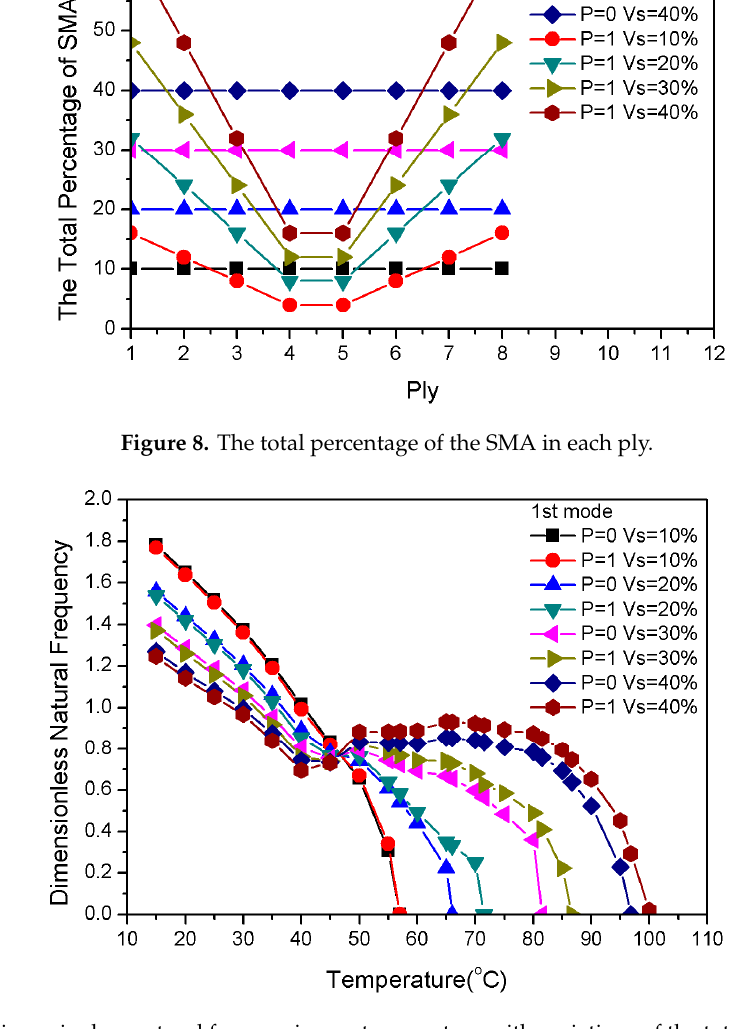
Figure 9. Dimensionless natural frequencies vs. temperature with variations of the total SMA content.